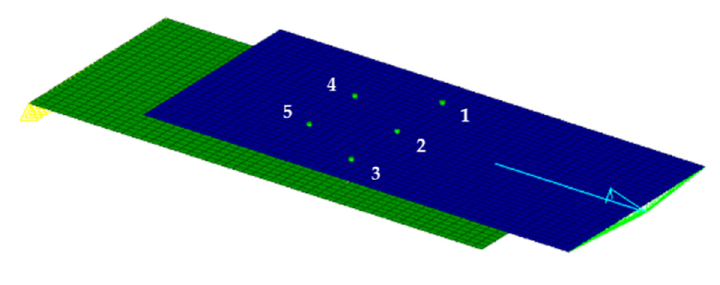
Figure 10. Schematic diagram of finite element model of the five-bolt joint.